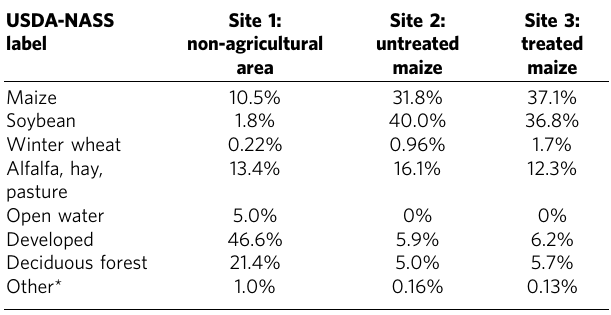
Table 7 | List of 65 pesticides screened in honey bee